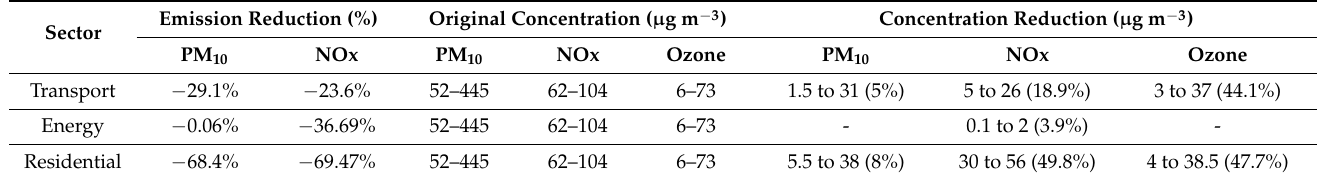
Table 2. Sector-wise percentage reduction in emissions and the corresponding reduction in ambient